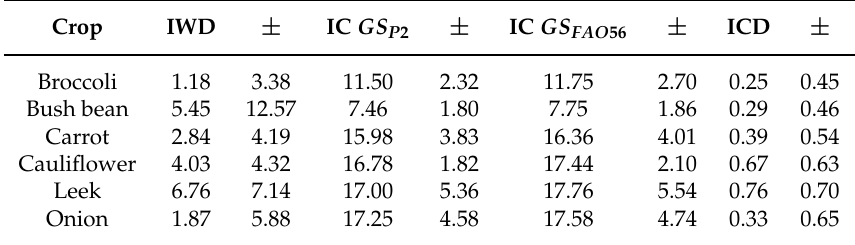
Table 2. Simulation results comparing GS P 2 and GS FAO 56 ( GS P 2 water differences (%) (IWD), mean irrigation counts for both models (IC GS P 2 , IC GS FAO 56 ), and mean irrigation count differences (ICD) and their corresponding standard